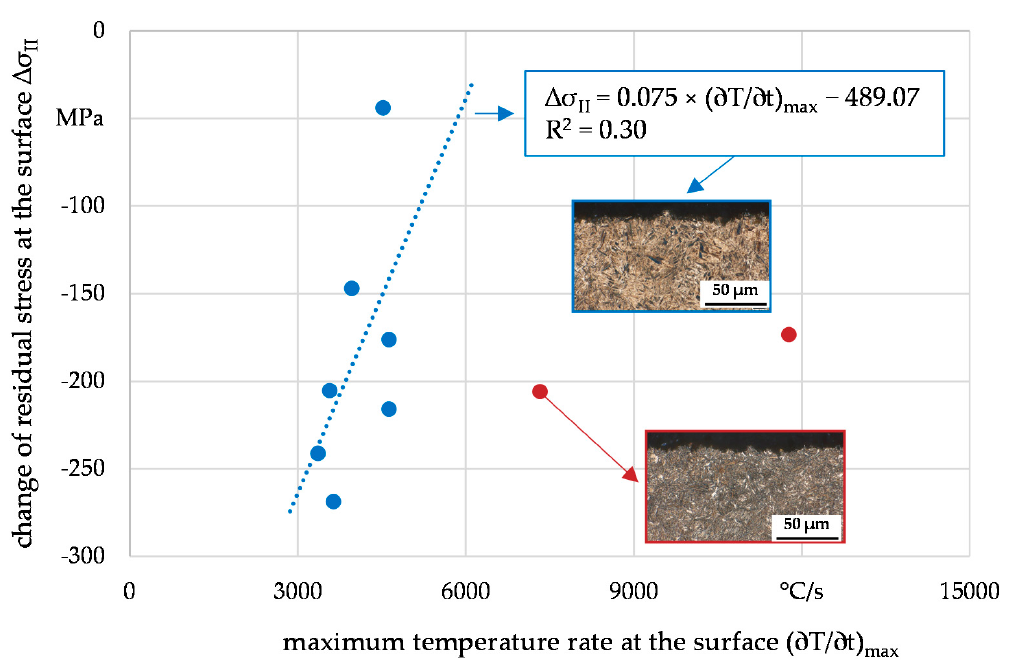
Figure 15. Change of residual stresses at the surface dependent on the maximum temperature rate in consideration of metallographic cross-section analysis (blue: no visible heat-affected zone; red: visible heat-affected zone). As a second approach, the correlation between the residual stress change and the Hollomon–Jaffe parameter is investigated, which is illustrated in Figure 16. The Hollomon– Jaffe parameter is again determined according to Equation (1).